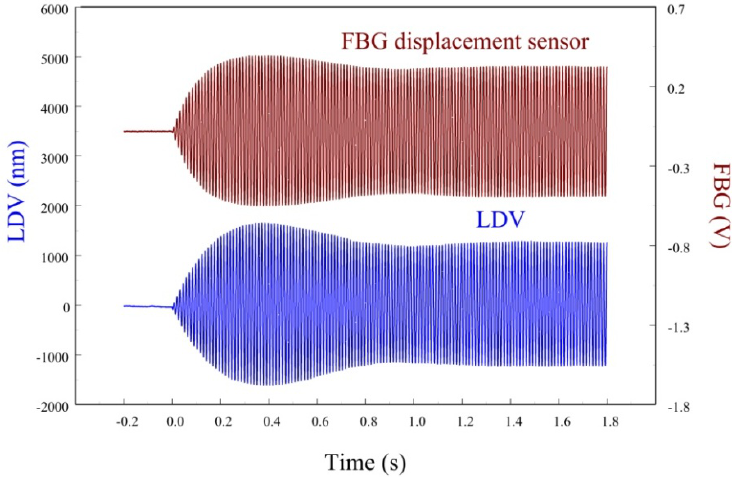
Figure 19. Transient displacement responses of the smart cantilever beam excited by the piezoelectric actuator at 76 Hz.